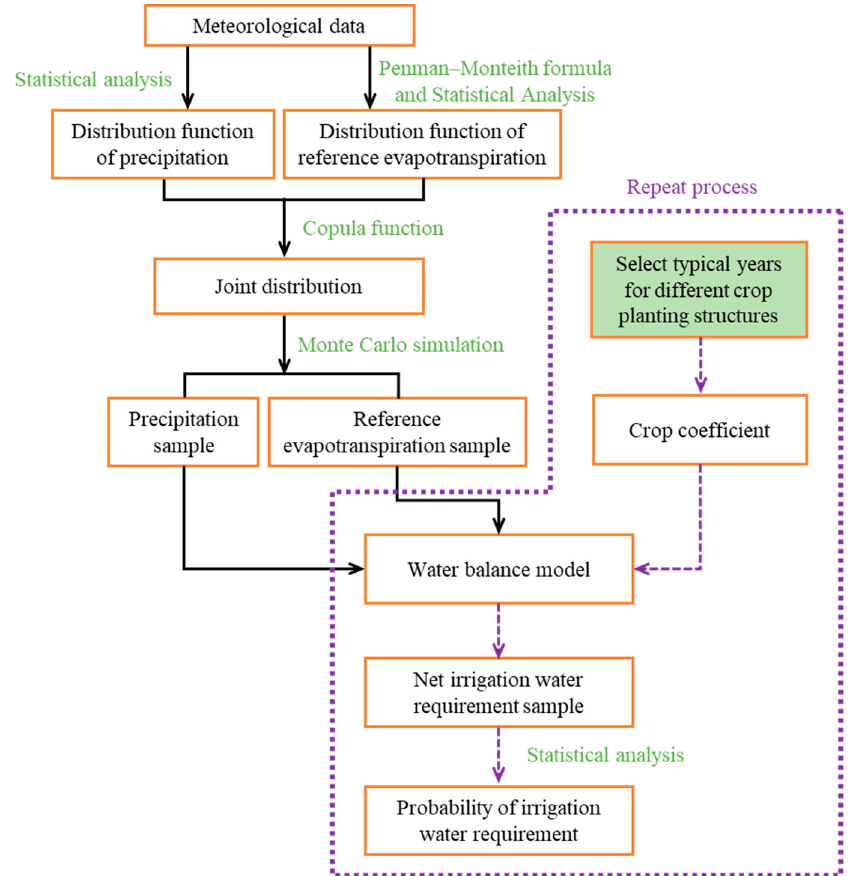
Figure 1. Process diagram of Copula function–Monte Carlo method. (Purple line and arrows are processes that need to be repeated, black arrows do not need to be repeated)